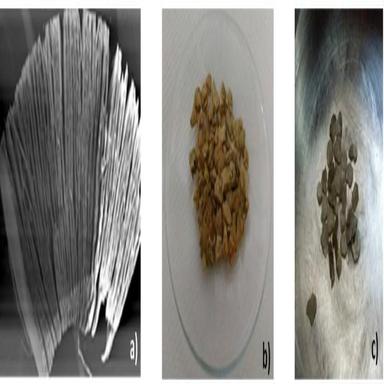
(a) pristine expanded Vermiculite; (b) LiCl/Vermiculite synthesized composite; (c) LiCl/Vermiculite after 14 sorption/desorption cycles.